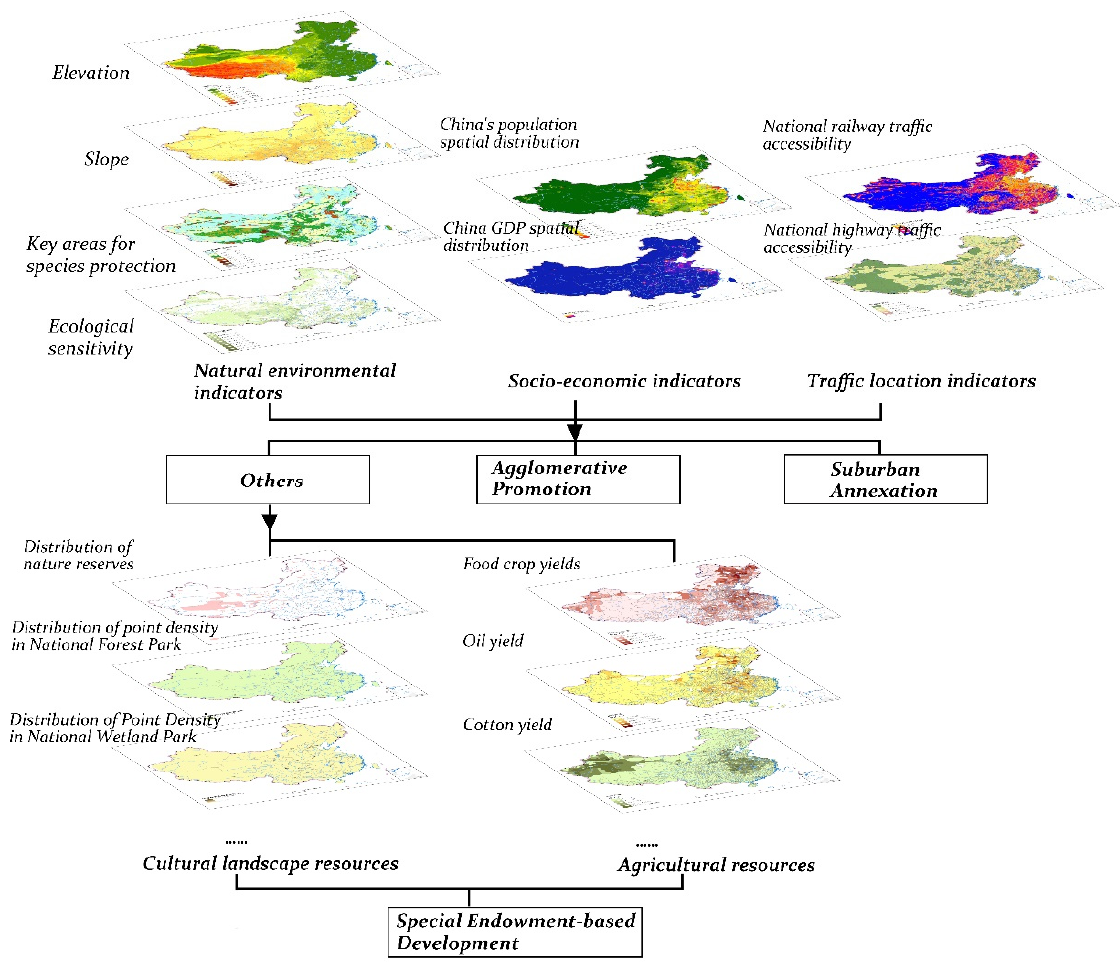
Figure 3. Data with Map Visualization.